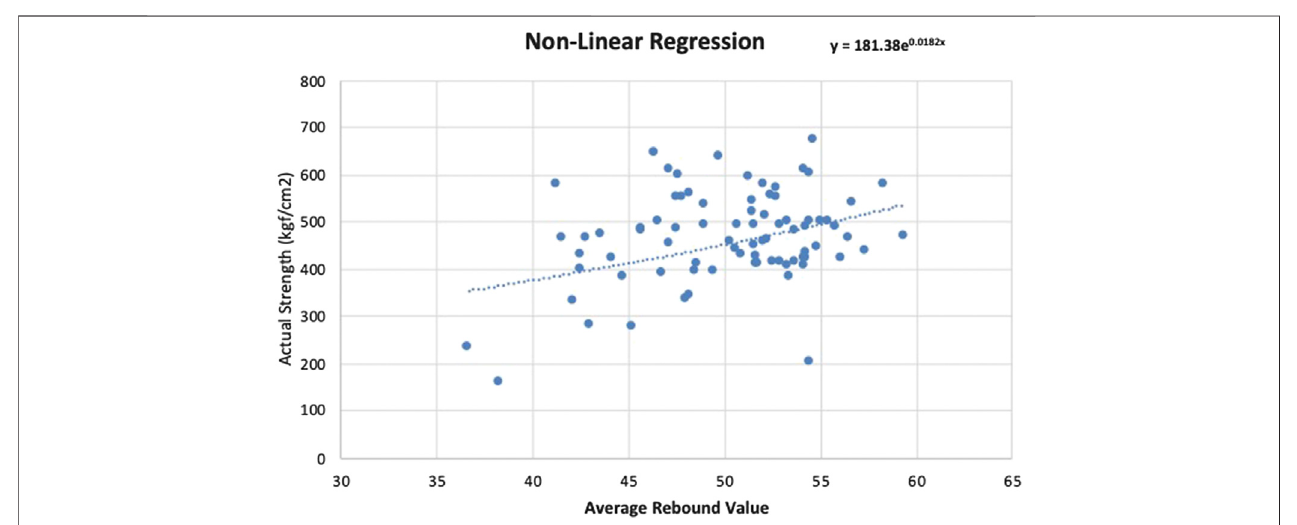
FIGURE 8 | Nonlinear regression